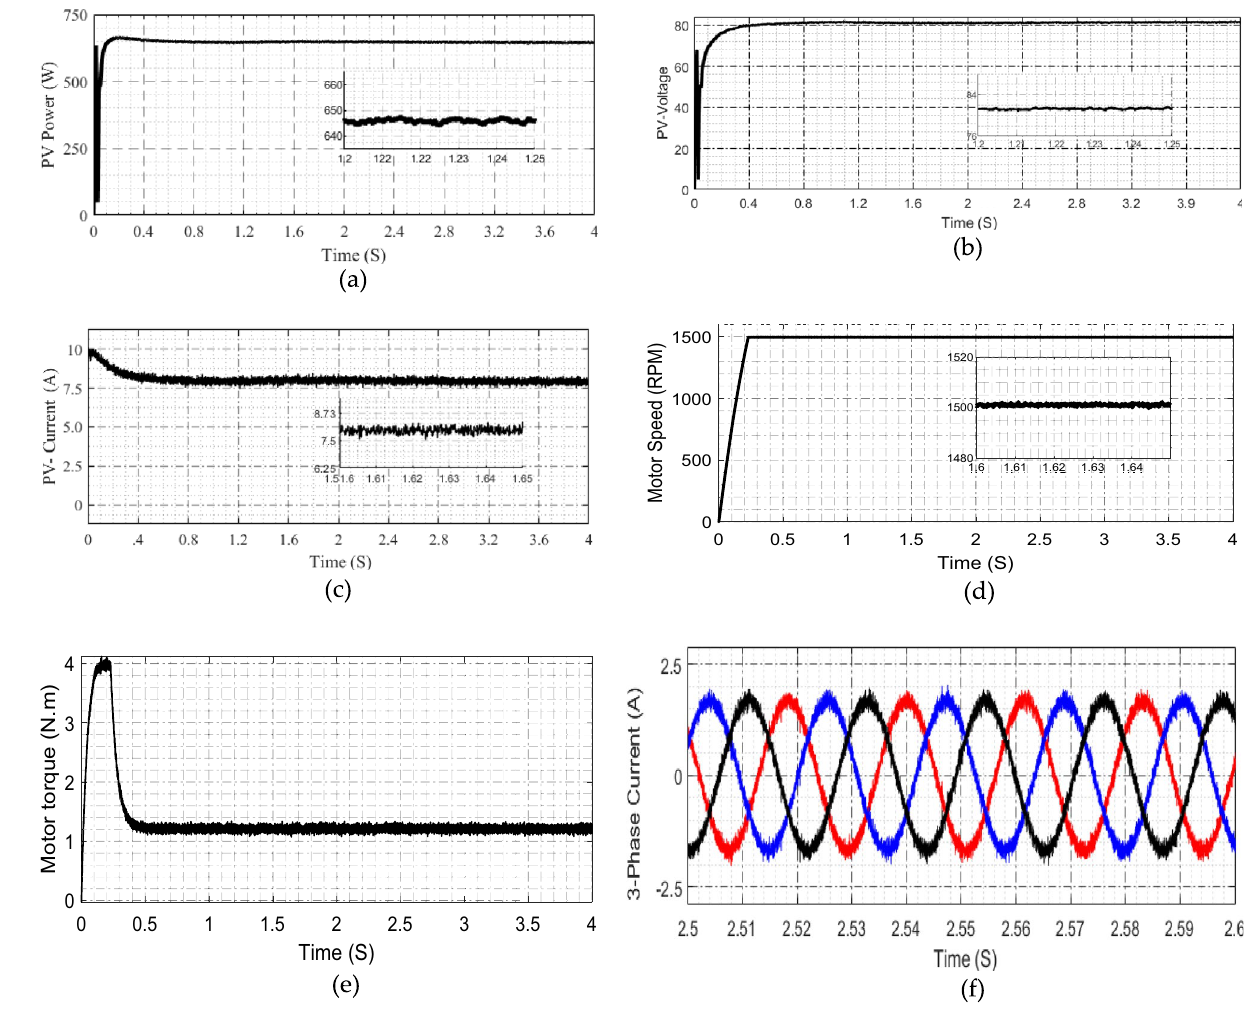
Figure 11. Experimental results at Irradiation 1000 W/m 2 ( a ) PV-power ( b ) PV-voltage ( c ) PV-current ( d ) voltage after high gain cell motor speed ( e ) motor torque ( f ) motor phase